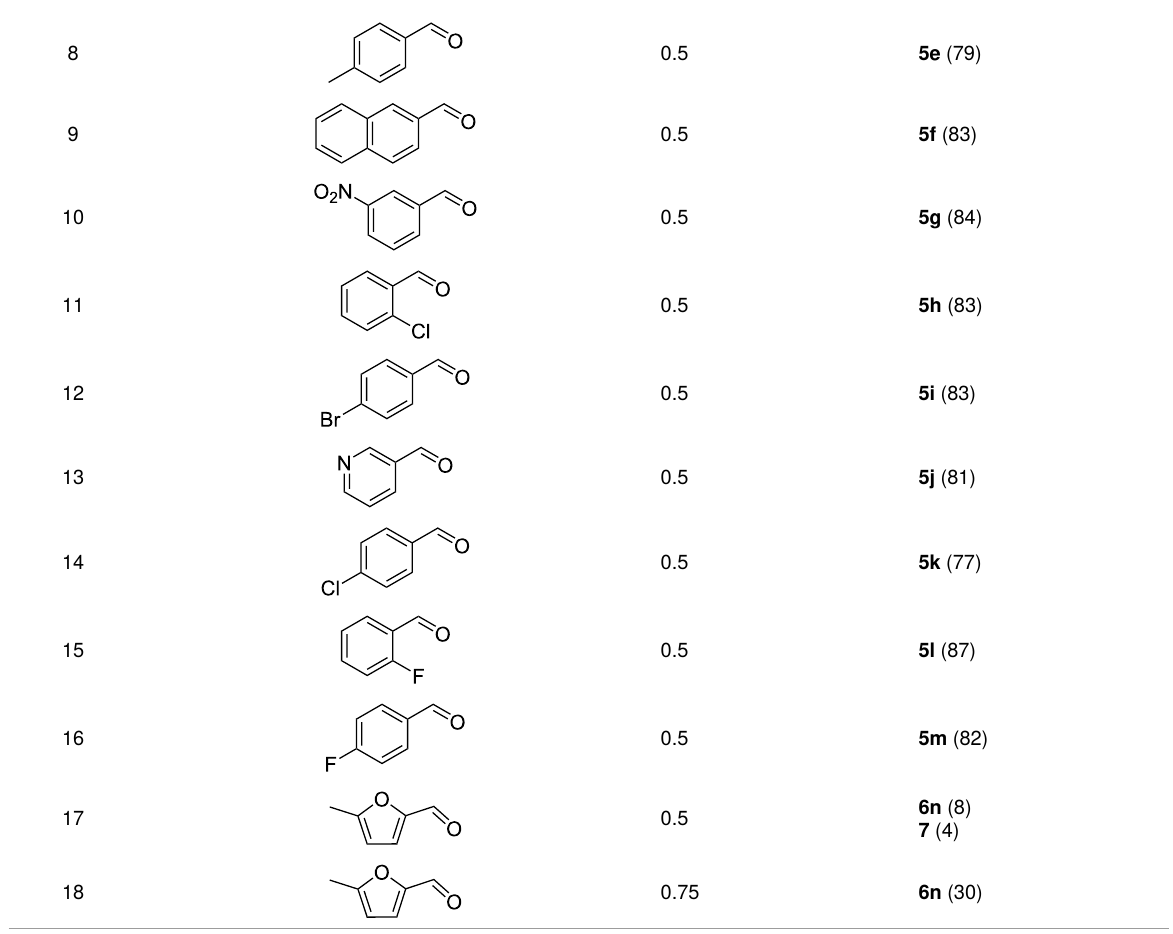
Table 1: Reactions of enone 1 and aldehydes promoted by NaOMe in MeOH.